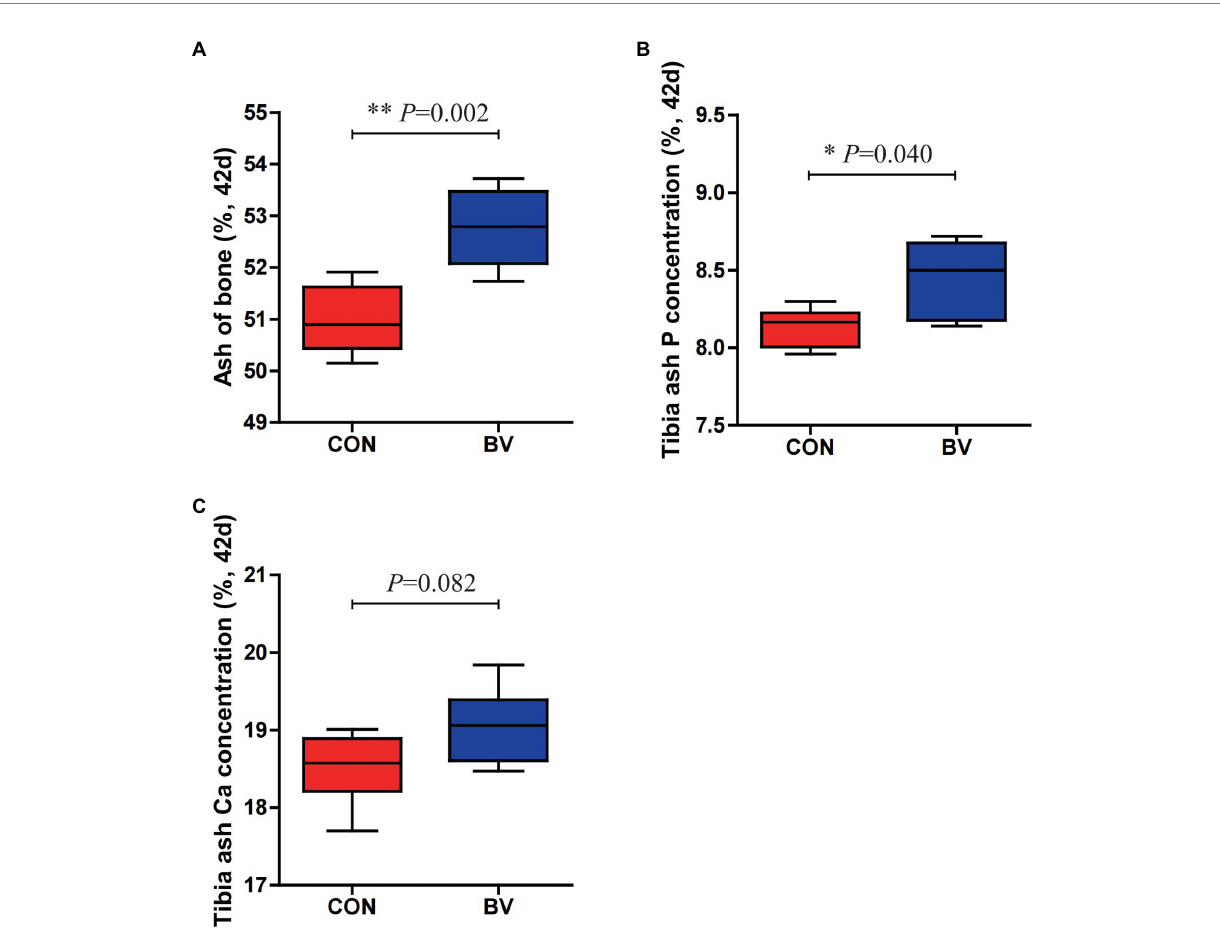
FIGURE 5 Effect of Bacillus velezensis LB-Y-1 on tibia bone mineralization of broilers ( n = 6). (A) Bone ash content at 42 days of age. (B) Tibia ash P concentration at 42 days of age. (C) Tibia ash Ca concentration at 42 days of age. Values are presented as Mean ± SEM, the values having superscript (*) were significantly different, * p < 0.05; ** p <